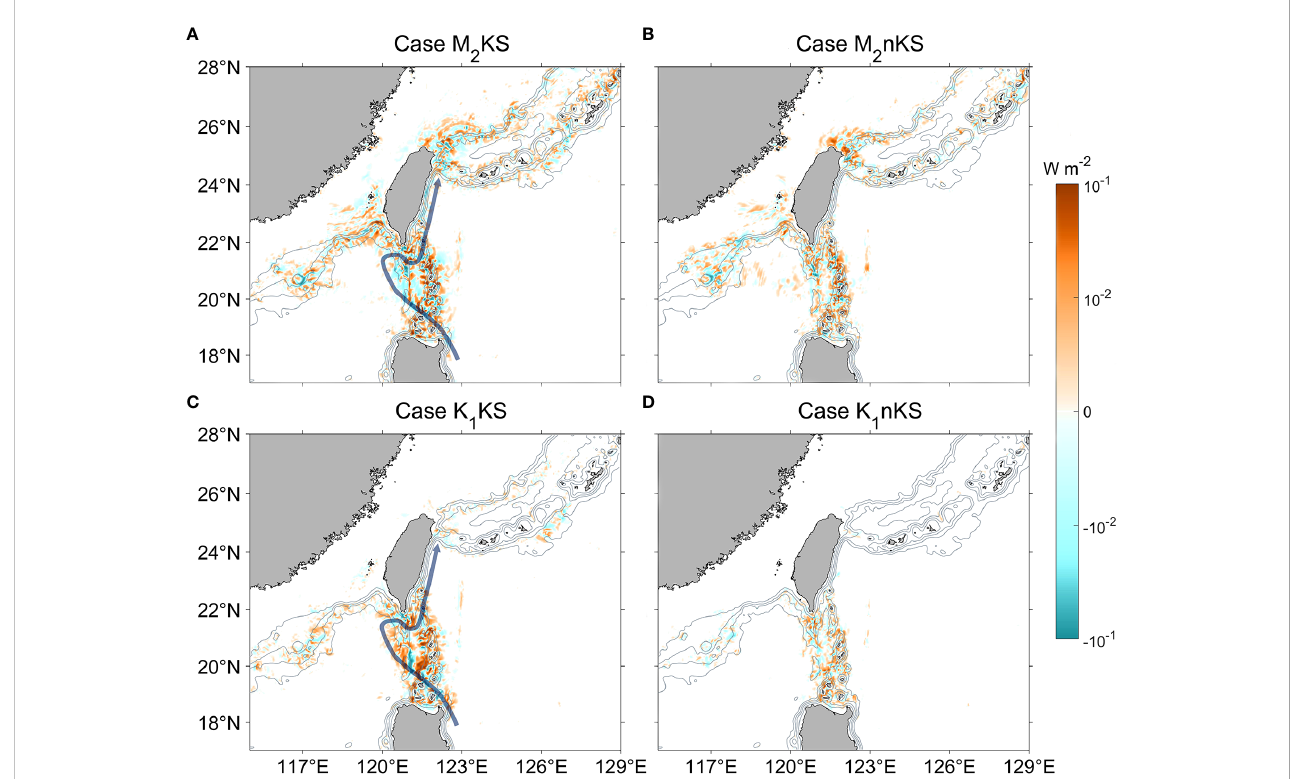
FIGURE 9 Distribution of Ibt-bc (color, W m-2) for four summer cases. (A) M2KS. Gray contours indicate isobaths. The blue line shows the Kuroshio path during the simulation period. (B) M2nKS. (C) K1KS. (D) K1nKS. Left column is with-Kuroshio, right without.